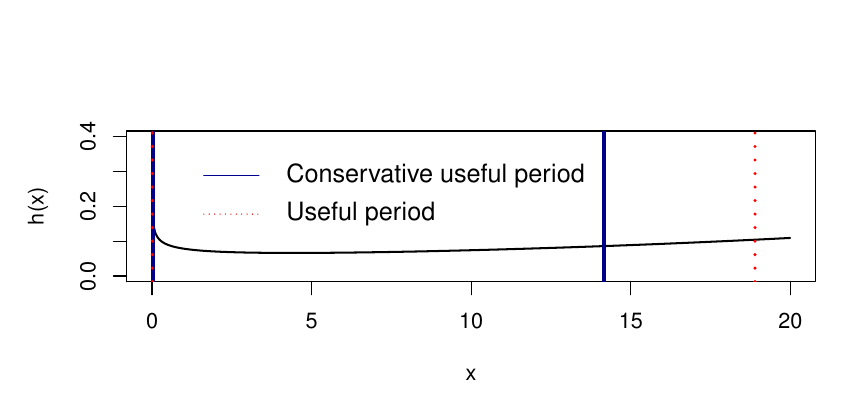
Figure 3 – The useful periods of EMW distribution hazard rate function with β = 0.097, ν = 0.785, λ = 0.012, θ =